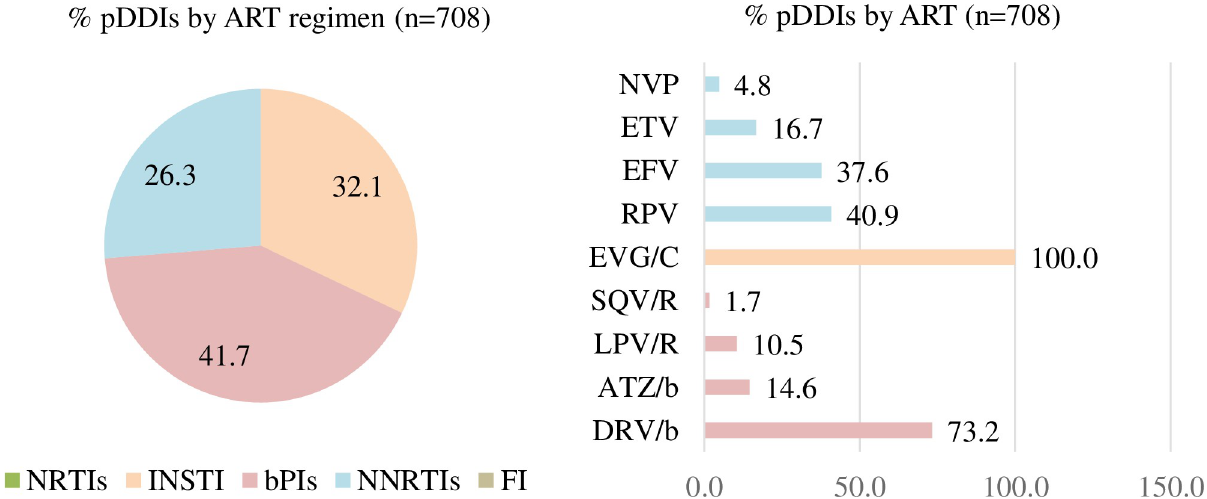
Fig 3. Prevalence of interactions per antiretroviral regimen. NRTIs: Nucleos(t)ide reverse transcriptase inhibitors; INSTI: Integrase strand transfer inhibitors; bPIs: Boosted-protease inhibitors; NNRTIs: Non-nucleos(t)ide reverse transcriptase inhibitors; FI: Fusion inhibitors; RPV: Rilpivirine; NVP: Nevirapine; ETV: Etravirine; EFV: Efavirenz; EVG/C: Elvitegravir/cobicistat; SQV/R: Saquinavir/ritonavir; LPV/R: Lopinavir/ritonavir; ATZ/b: Atazanavir boosted; DRV/b: Darunavir boosted; ART: Antiretroviral; pDDIs: Potential drug-drug interaction. n: number of pDDIs.